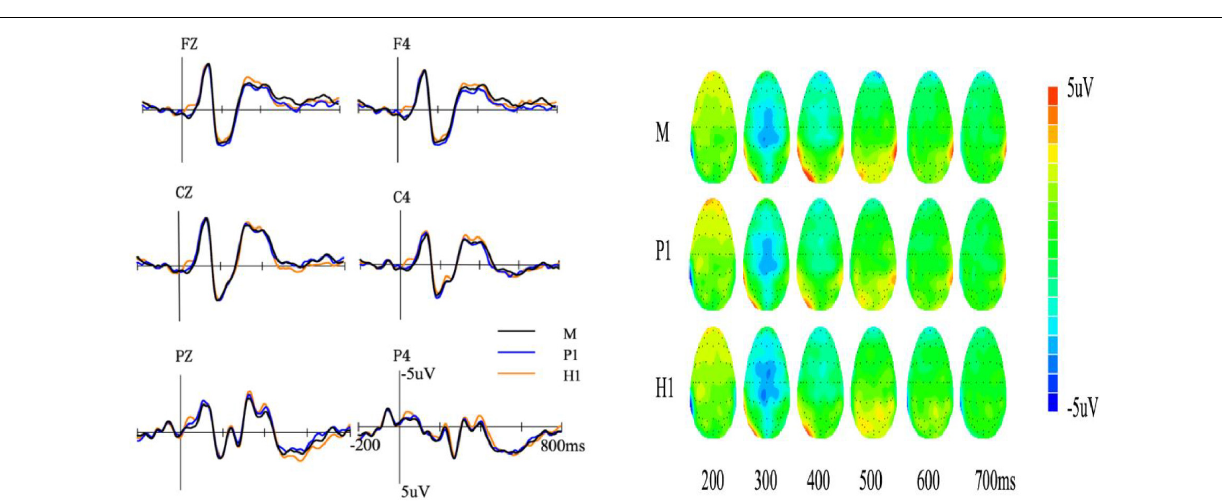
central and right) repeated measures ANOVA. Results showed